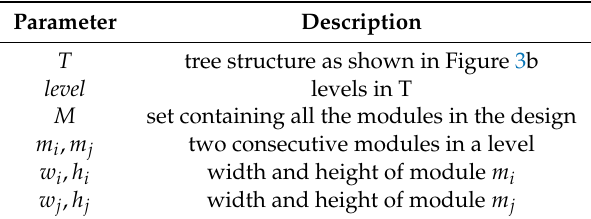
Table 1. Parameter description in Algorithms 1 and